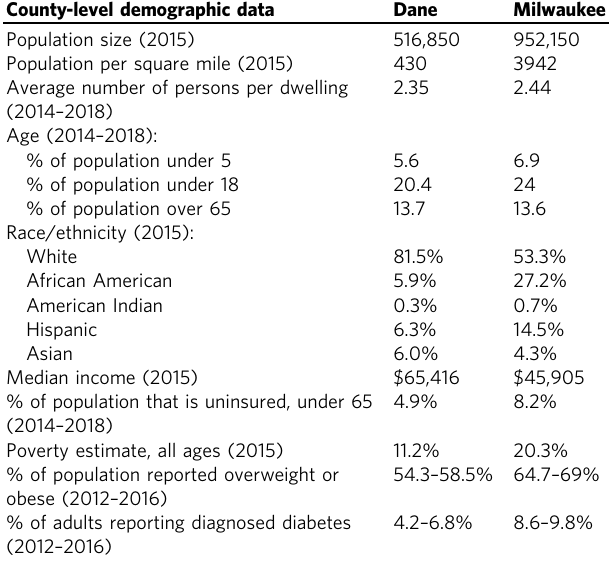
Table 1 County-level demographics for Dane and Milwaukee